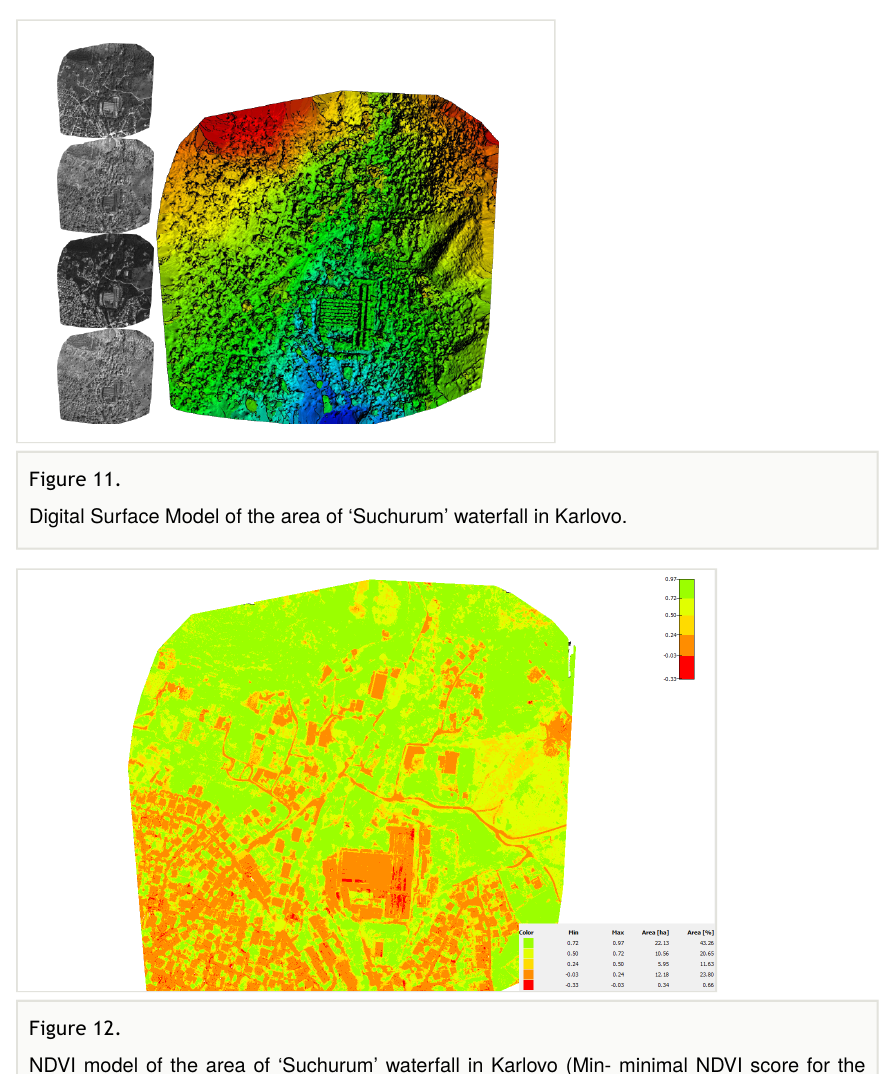
Figure 12. NDVI model of the area of ‘Suchurum’ waterfall in Karlovo (Min- minimal NDVI score for the class, max-maximal NDVI score for the class, area (ha) total area of the NDVI class, area (%)- relative share of the NDVI class within the studied